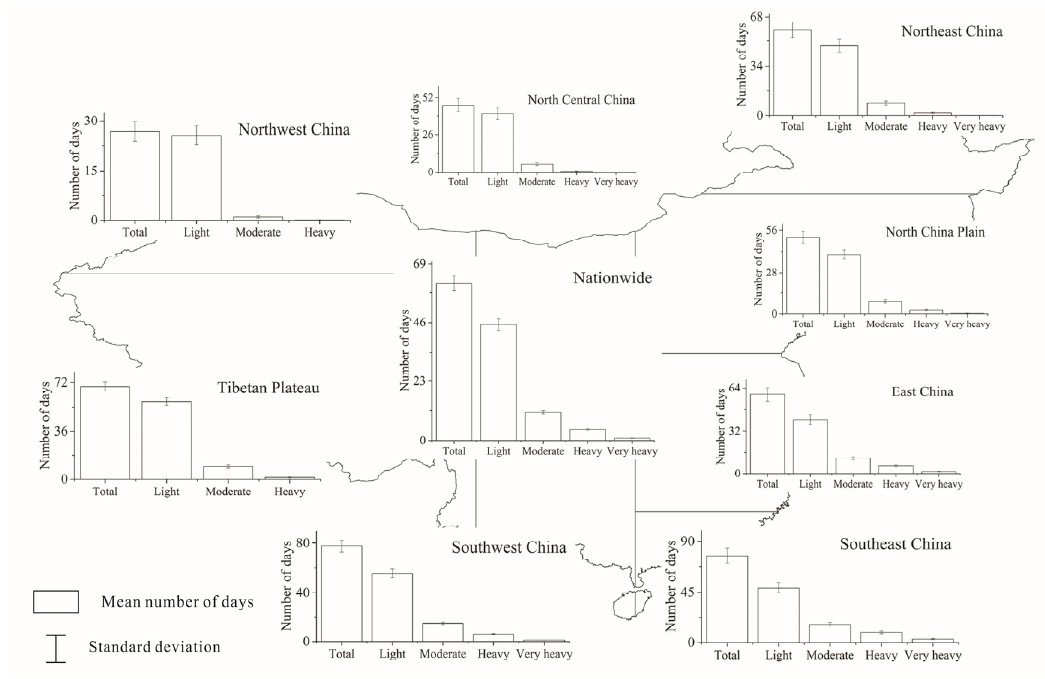
Figure 3. Distribution of long-term (1960–2018) mean number of rain-season precipitation with different grades.